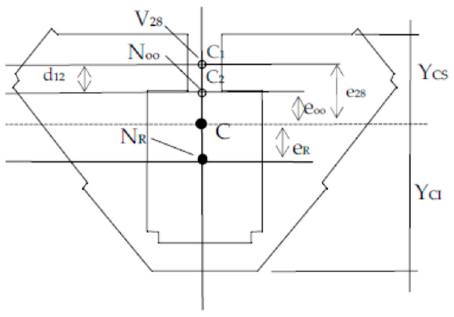
Figure 13. Position of the pillar hollow section center.